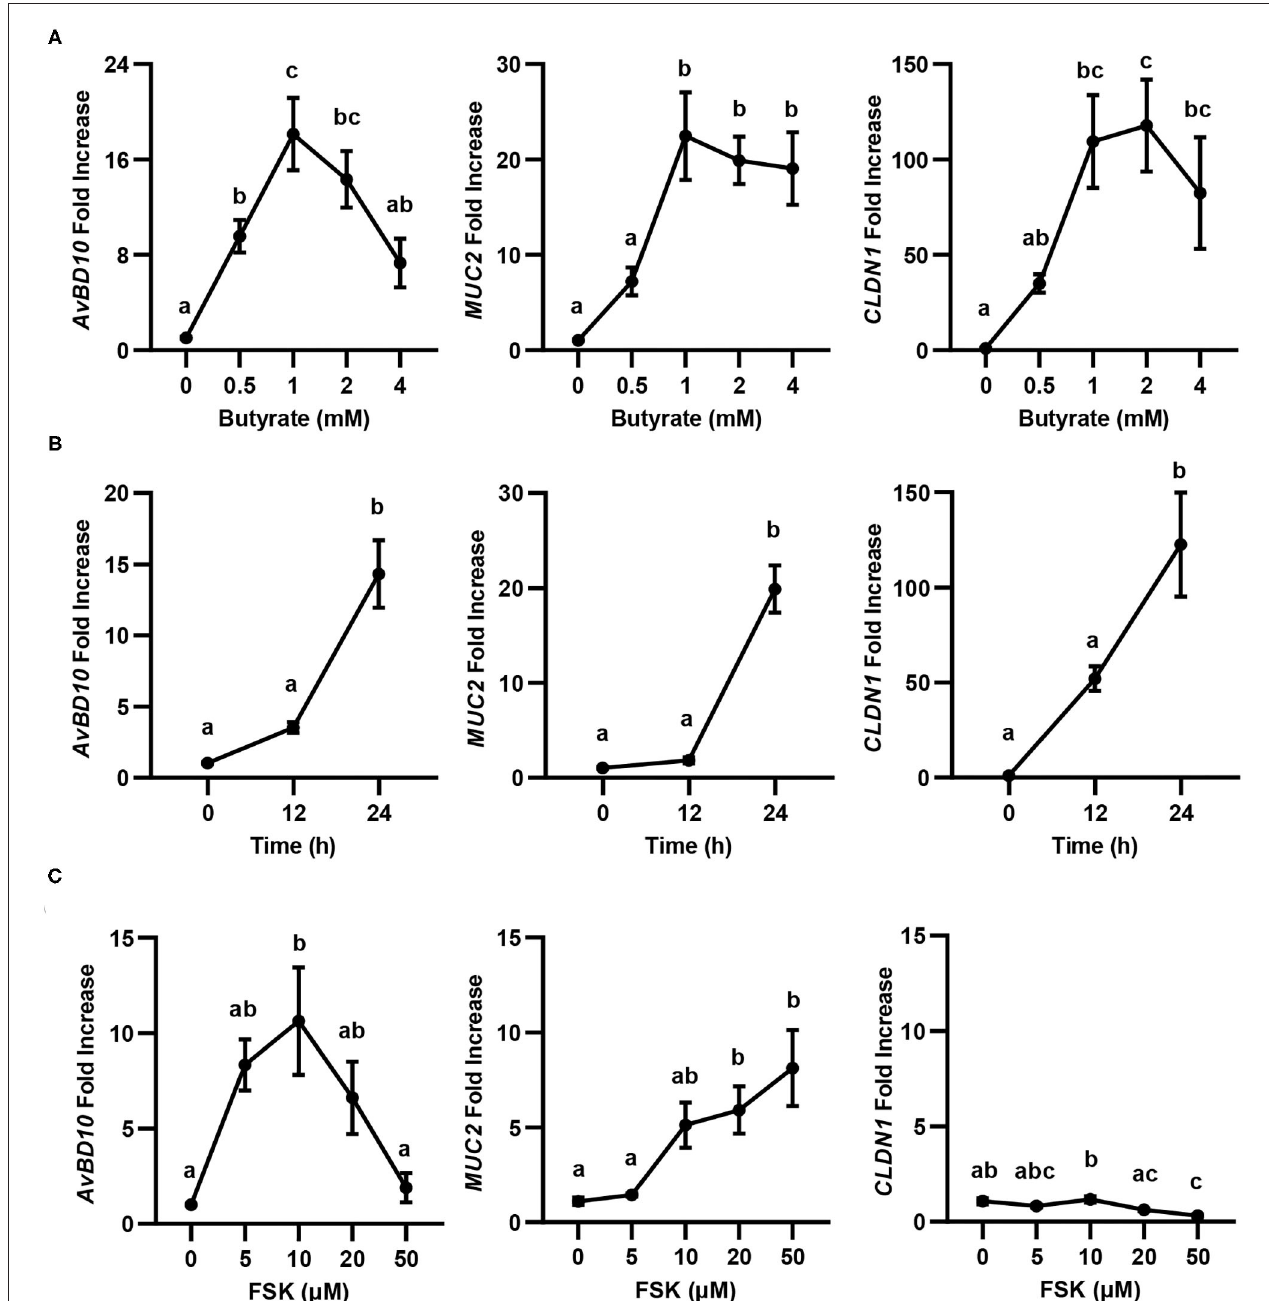
FIGURE 1 | Concentration- and time-dependent induction of avian β -defensin 10 ( AvBD10 ), mucin 2 ( MUC2 ), and claudin 1 ( CLDN1 ) in macrophages by butyrate and forskolin (FSK). Chicken HD11 cells were stimulated in duplicate with different concentrations of sodium butyrate or FSK for 24h, or 2mM butyrate for 12 or 24h, followed by RT-qPCR analysis of gene expression. (A) Concentration-dependent gene induction in response to butyrate for 24h. (B) Time-dependent gene induction in response to 2mM butyrate. (C) Concentration-dependent gene induction in response to FSK for 24h. Results are shown as means ± SEM of 3–4 independent experiments. Statistical significance ( P < 0.05), denoted by non-common letters, was determined using one-way ANOVA and post-hoc Tukey’s test.